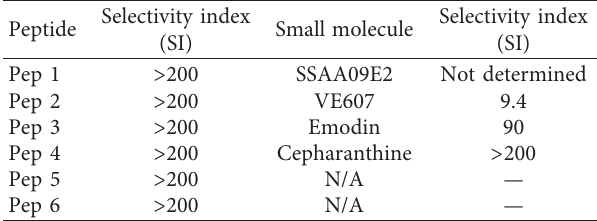
Table 1: Summary of selectivity indices of peptides and small molecules tested against ACE2 :S1 RBD binding.